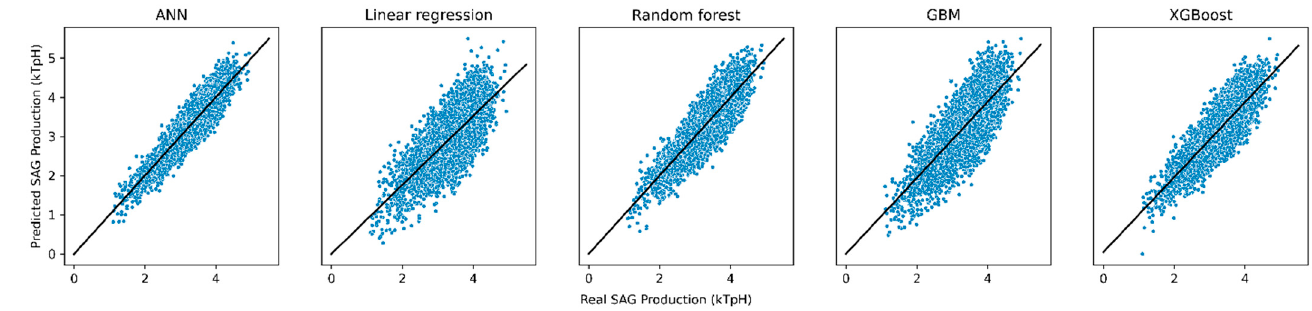
Figure 4. Scatterplots of real production versus predicted production of adjusted ML